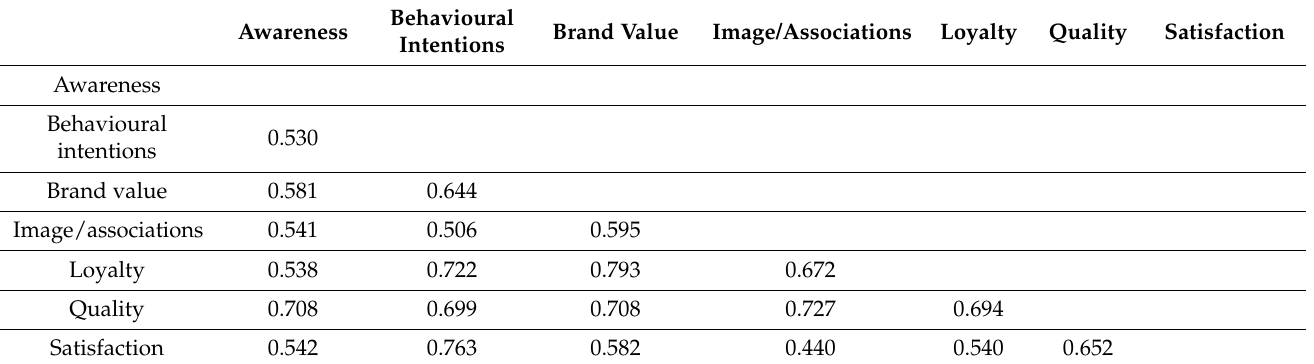
Table 5. Discriminant validity: Heterotrait-Monotrait Ratio